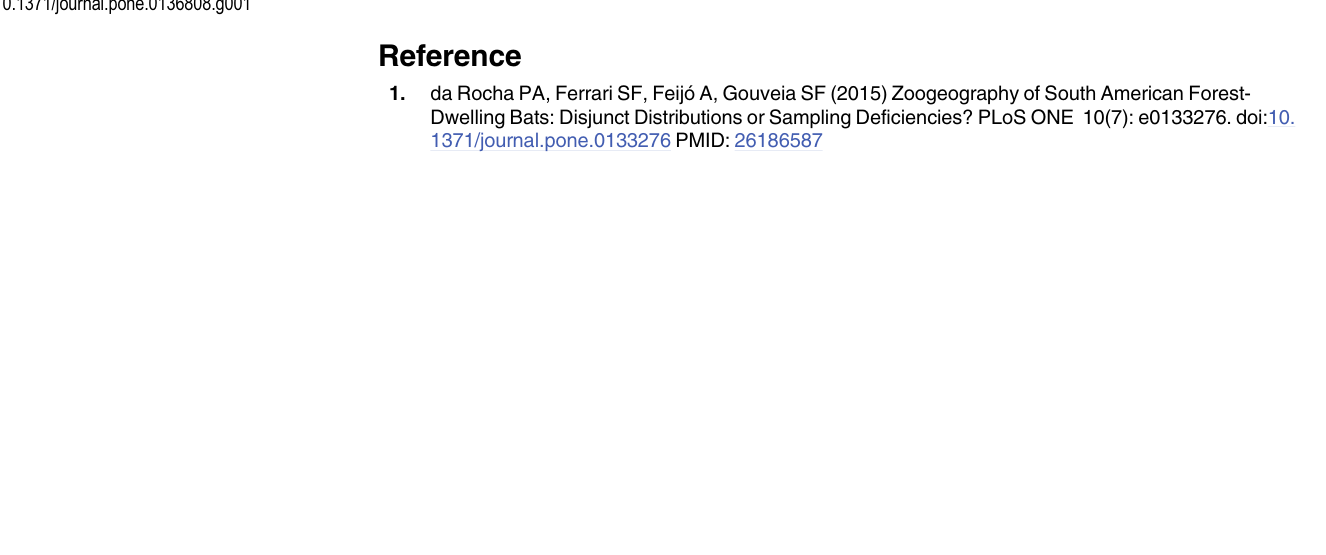
PLOS ONE | DOI:10.1371/journal.pone.0136808 August 20,